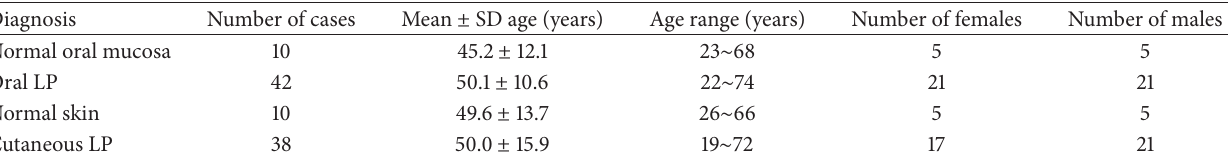
Table 1: Baseline characteristics of the study patients with lichen planus (LP) and controls.